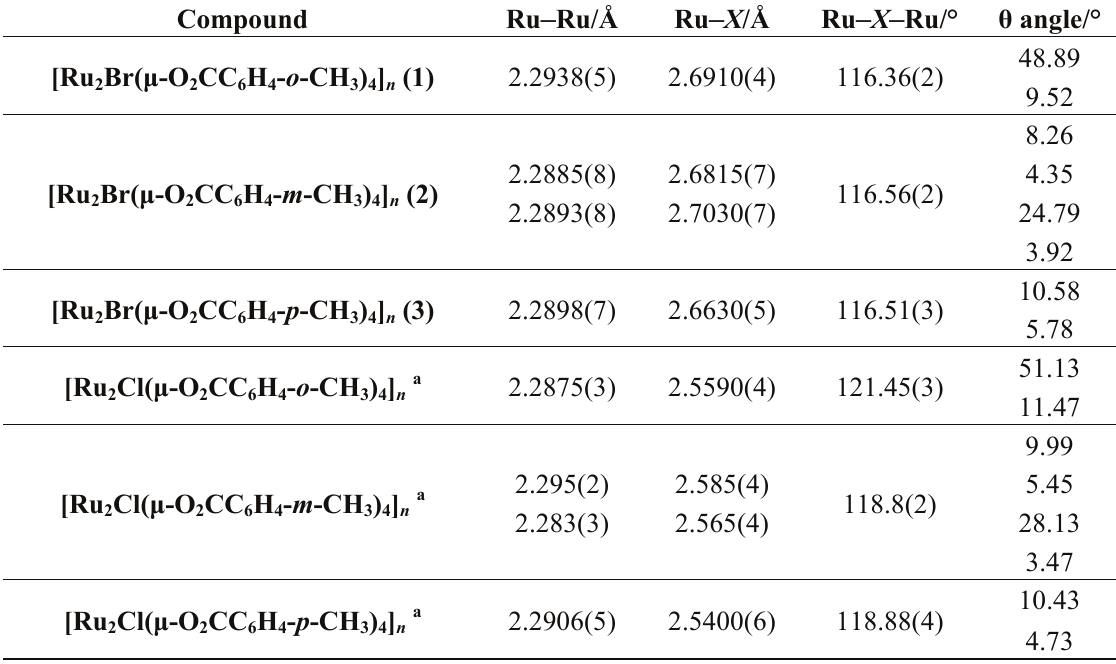
Table 1. Bond distances and angles in compounds 1 – 3 and in the carboxylate